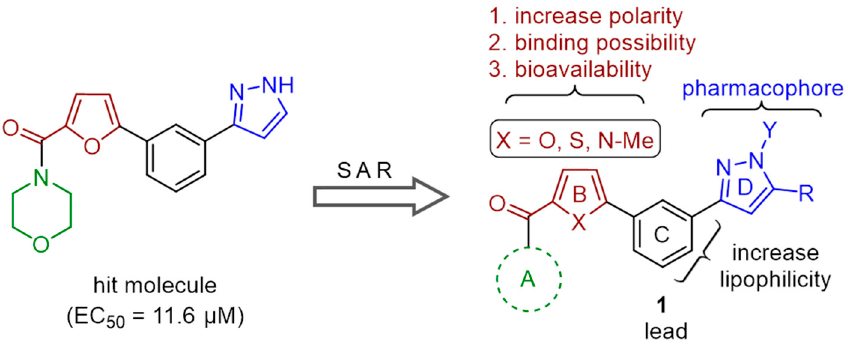
Figure 1. Design of new hinged compounds 1 to inhibit enterovirus.